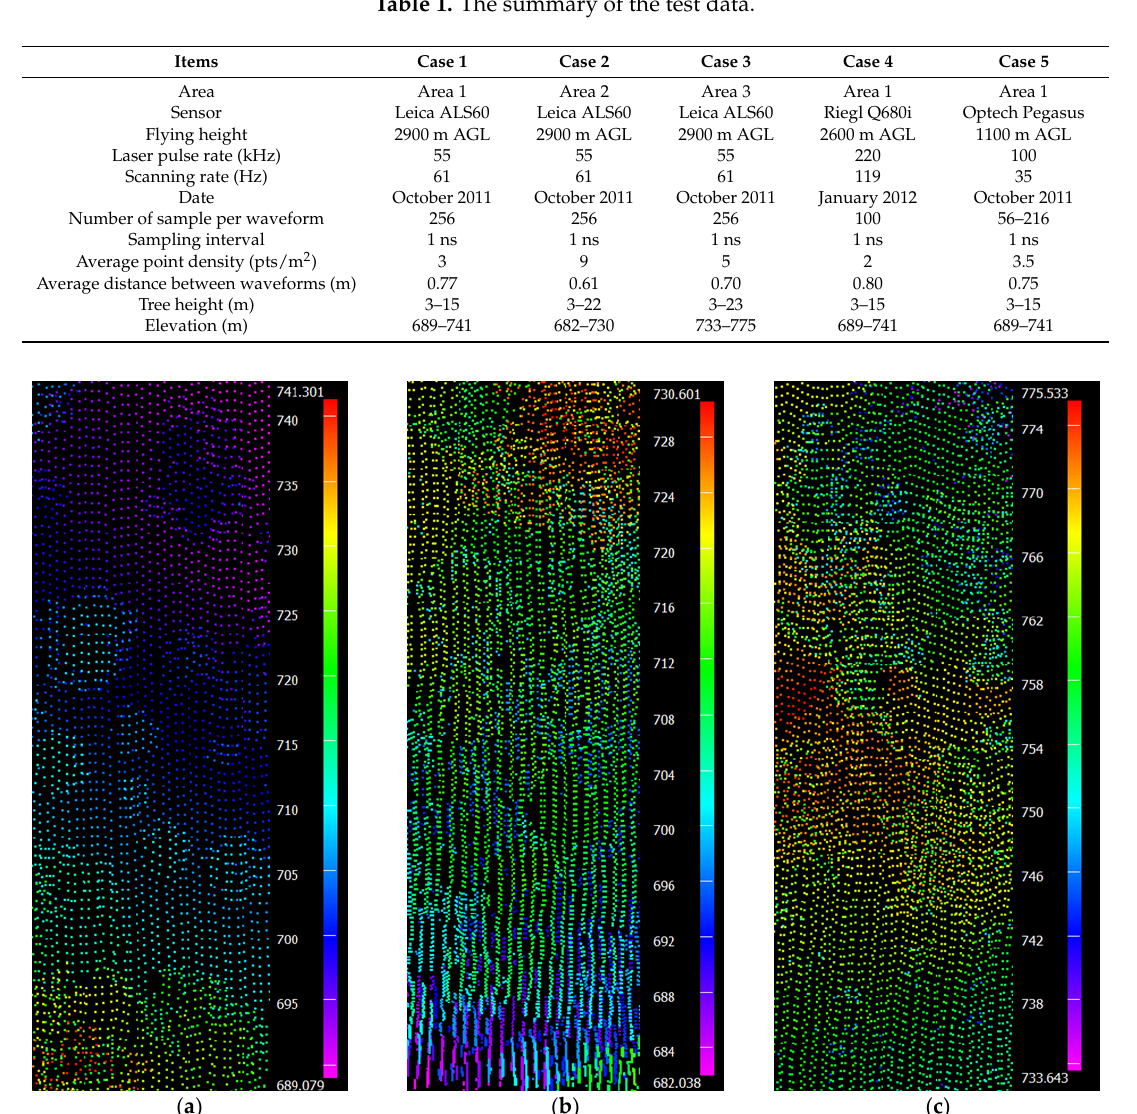
Figure 5. The original lidar points from Leica ALS60: ( a ) Area 1 with lower tree density; ( b ) Area 2 with medium tree density; ( c ) Area 3 with higher tree density.